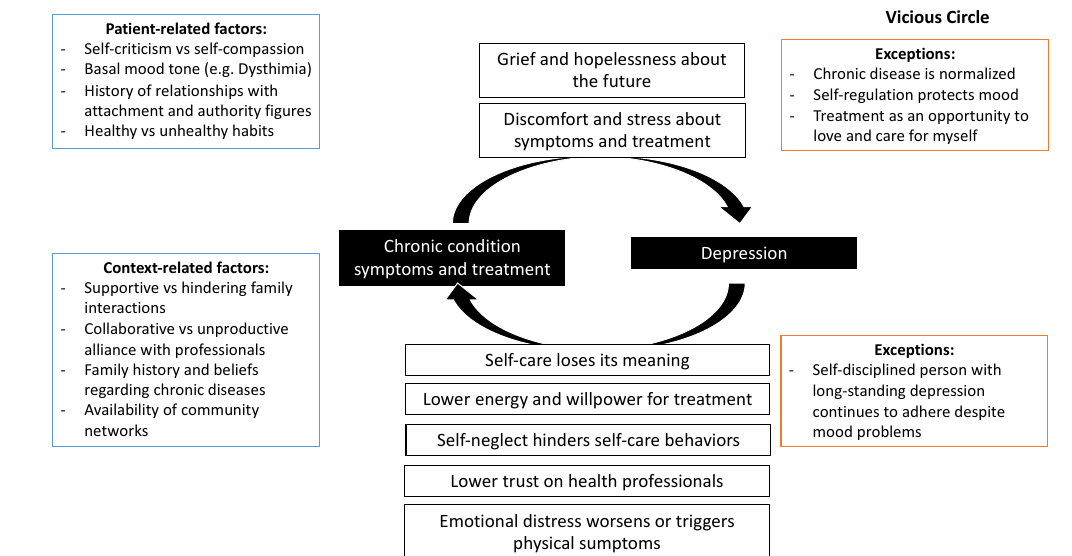
Figure 1. Common vicious circle between chronic conditions and depression.